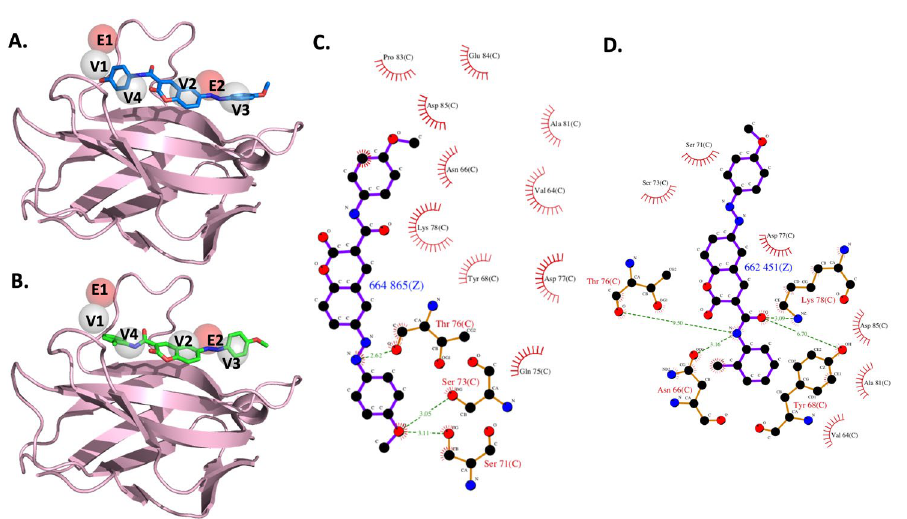
Figure 5. Docked compounds show a high binding affinity towards PD-1. ( A,B ) Visualization of the docked compounds with anchors in the human PD-1 structure, which is illustrated by the pink cartoon. Six anchors are shown as transparent red and gray spheres, while the docked CH-4 and CH-4.7 are shown as blue ( A ) and green ( B ), respectively. ( C,D ) The interaction diagrams between the proteins and docked ( C ) CH-4 or ( D ) CH-4.7 are shown as 2-D plots, which were examined by LIGPLOT 41